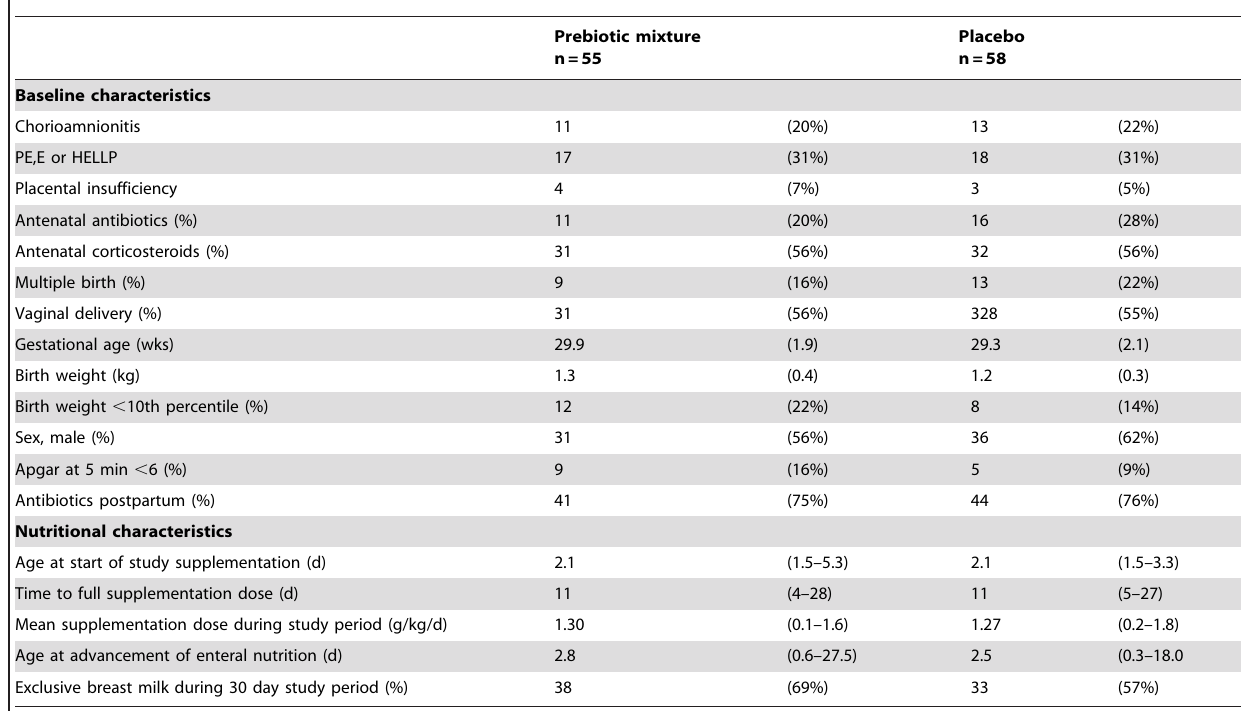
Table 1. Baseline and nutritional